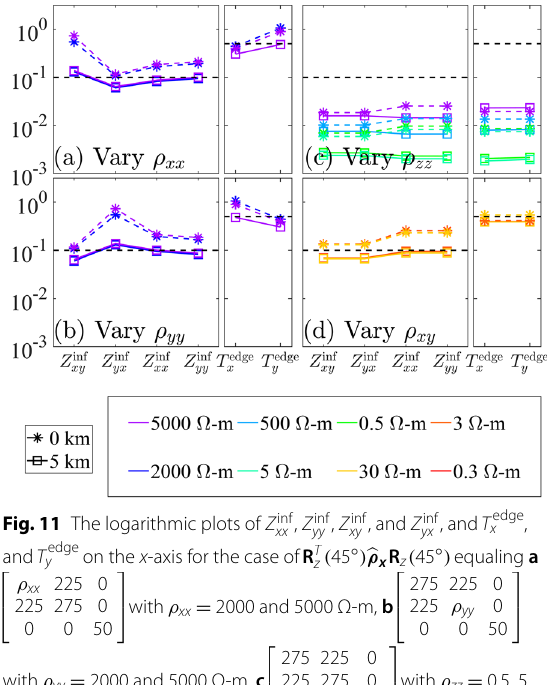
Fig. 11 The logarithmic plots of Z inf xx , Z inf yy , Z inf xy , and Z inf yx , and T edge x , and T edge y on the x ‑axis for the case of R T z ( 45 ◦ )